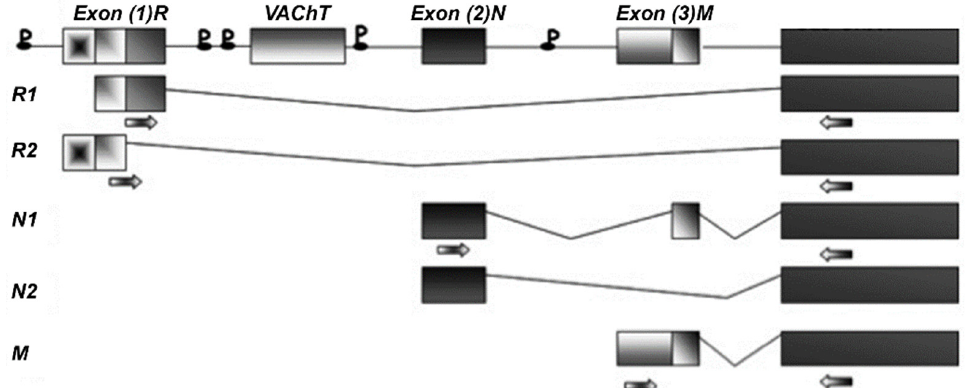
Figure 2. Schematic representation of the cholinergic gene locus. The VAChT gene is expressed in the first intron of ChAT gene. P indicates the various putative promoter sites regulating ChAT splice variant expression. Some of these promoters are in common with the VAChT gene. The arrows indicate the sites where the primers were designed.